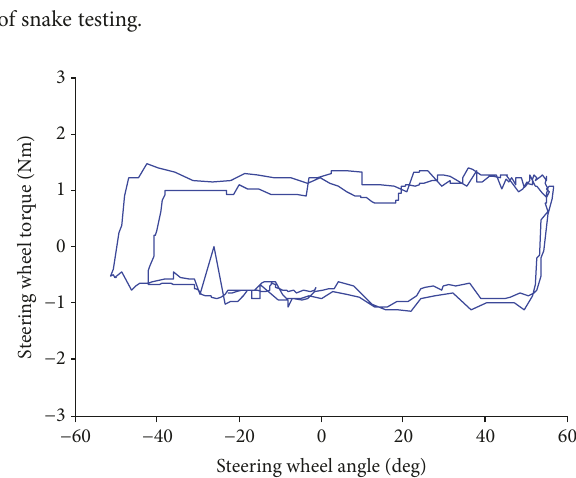
Figure 22: Vehicle speed of road test.